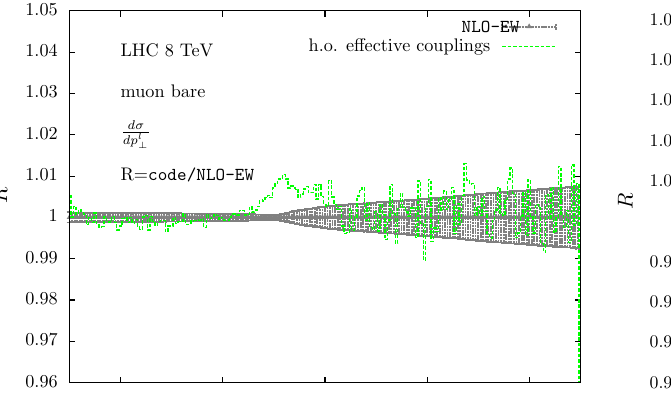
( left ), lepton-pair invariant mass ( right ) distributions for the 8 TeV LHC with ATLAS/CMS cuts. The results have been obtained with HORACE